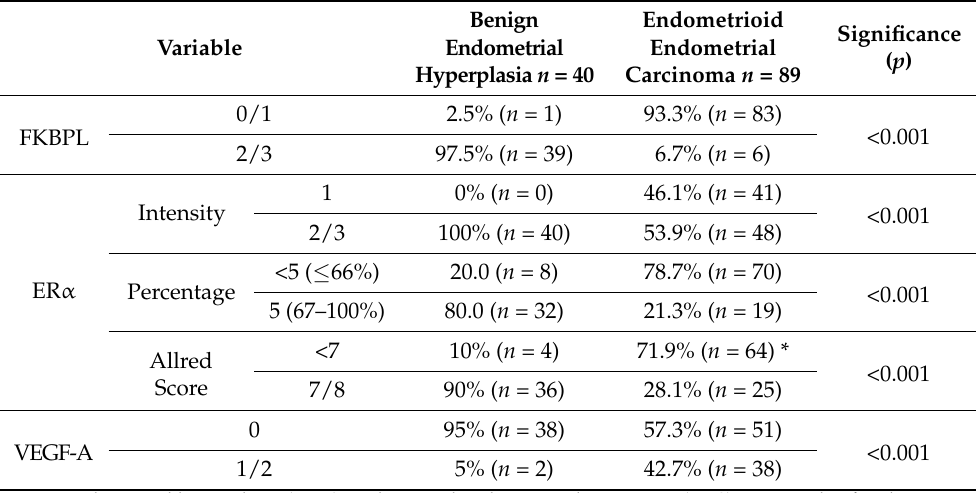
Table 3. Expression of FKBPL, VEGF-A, and ER α in BEH and